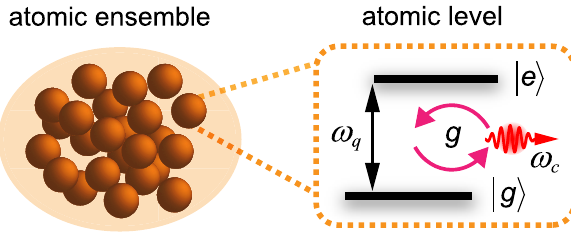
Figure 1: An atomic ensemble consisting of N identical two-level (cid:1)(cid:1)(cid:1) atoms with the ground state g 〉 and the excited state | e 〉 . Here, ω q is the atomic transition frequency, ω c the cavity frequency, and g the single-atom coupling to the cavity